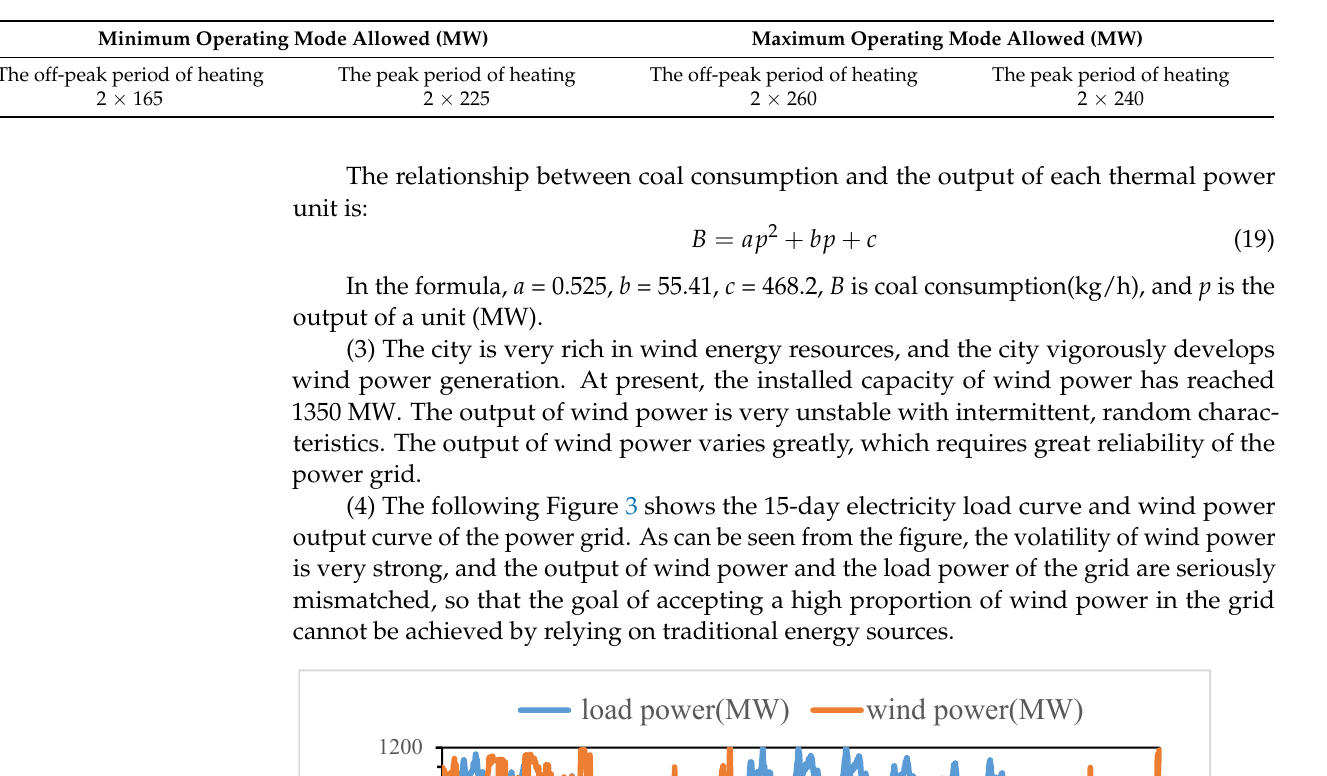
Table 2. The output constraints during heating.